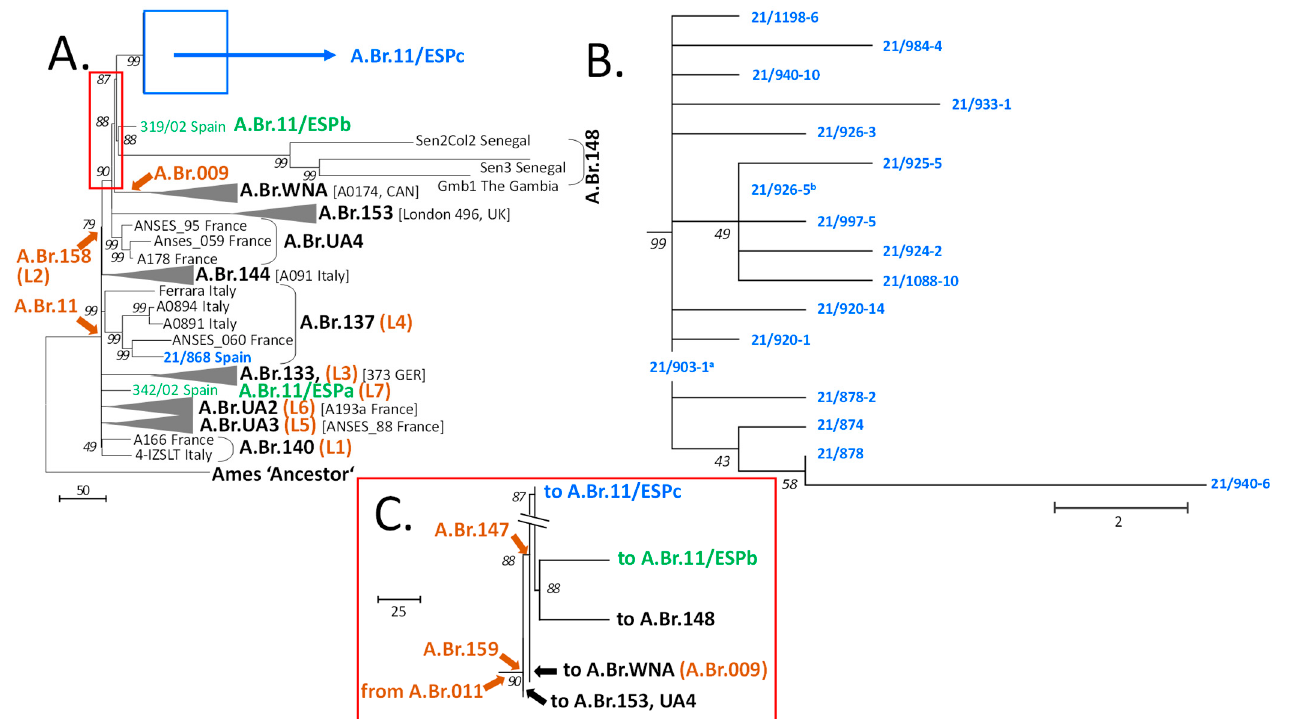
Figure 2. Rooted phylogenetic tree of Spanish B. anthracis and representatives of the A.Br.011/009 canonical single-nucleotide polymorphisms (canSNP) clade derived from chromosomal SNP analysis. A total of 1817 chromosomal SNPs were used to construct a maximum parsimony tree (bootstrap confidence values were generated from 500 permutations). ( A ) Overview tree to illustrate the general positions of Spanish strains within the A.Br.011/009 phylogeny. ( B ) Close-up of the diversity of new branch A.Br11/ESPc. ( C ) Close-up of branching after canSNP A.Br.159. To indicate the positions of additional branches, these are drawn as condensed down to a single representative (grey wedges with strain names in brackets). Branch names or relevant canSNP positions are set in black or brown bold characters, respectively. Previously identified Spanish strains and branches are colored in green and new strains and clades in blue. All other relevant isolate names and countries of origin are indicated at branch termini. The red and blue boxes in panel A indicate the sections shown in detail in panels B and C. The tree is rooted to the B. anthracis reference strain Ames ‘Ancestor’, which belongs to the A.Br.Ames clade. a identical chromosomal sequence to isolates 21/890-8; 21/890-9; 21/903-6; 21/905-13; 21/918-3; 21/926-9; 21/926-22; 21/940-19 and 21/955-9; b identical chromosomal sequence to isolates 21/891-2 and